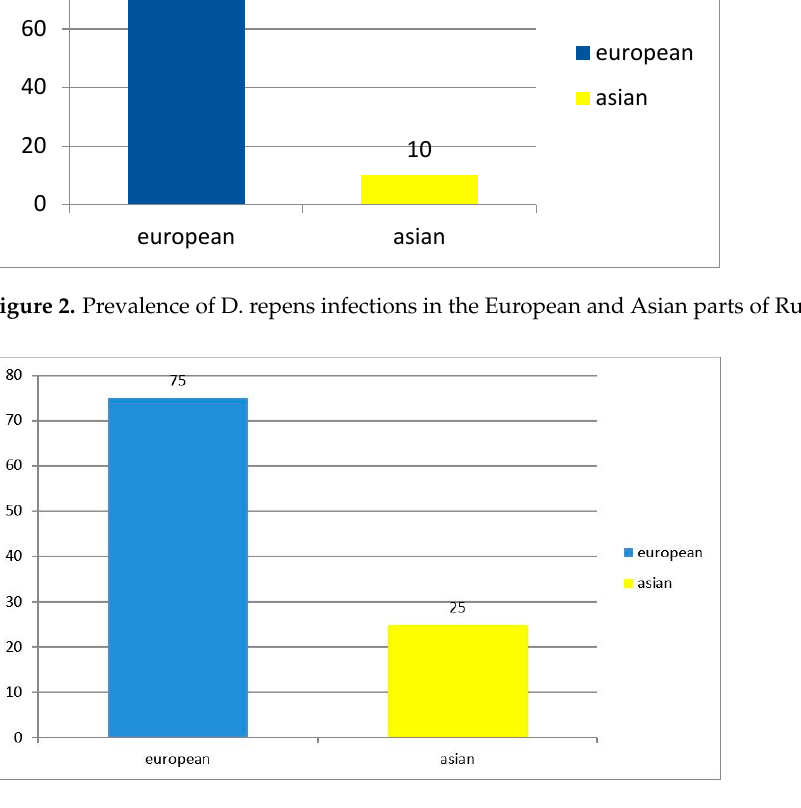
Figure 3. Prevalence of D. repens infection in the European and Asian parts of Russia, 2013–2018. As of 2018, out of the 83 administrative units in the territory of the Russia (hierar- chical order: Republic, Territory, Region, Autonomous district, District), indigenous cases of D. repens infection were recorded in 54. Their geographical positions are shown in Table 2. Table 2. Geographical positions of the administrative territories with local transmission of D. repens , Russia, 2018.